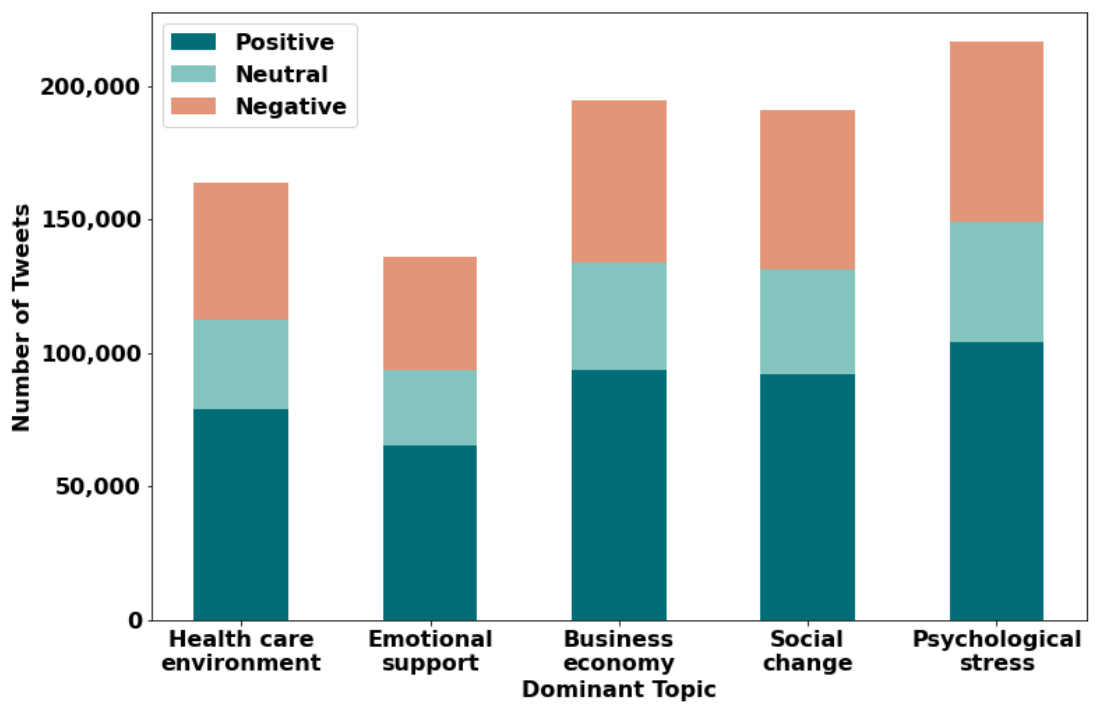
Figure 2. Frequency distribution of dominant topic tweets across sentiment types.